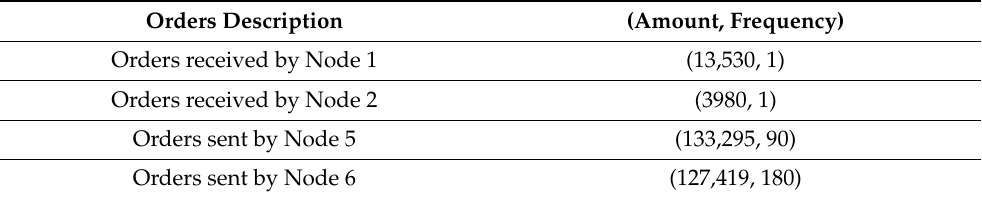
Table 11. Orders related to the outside of the network Topology